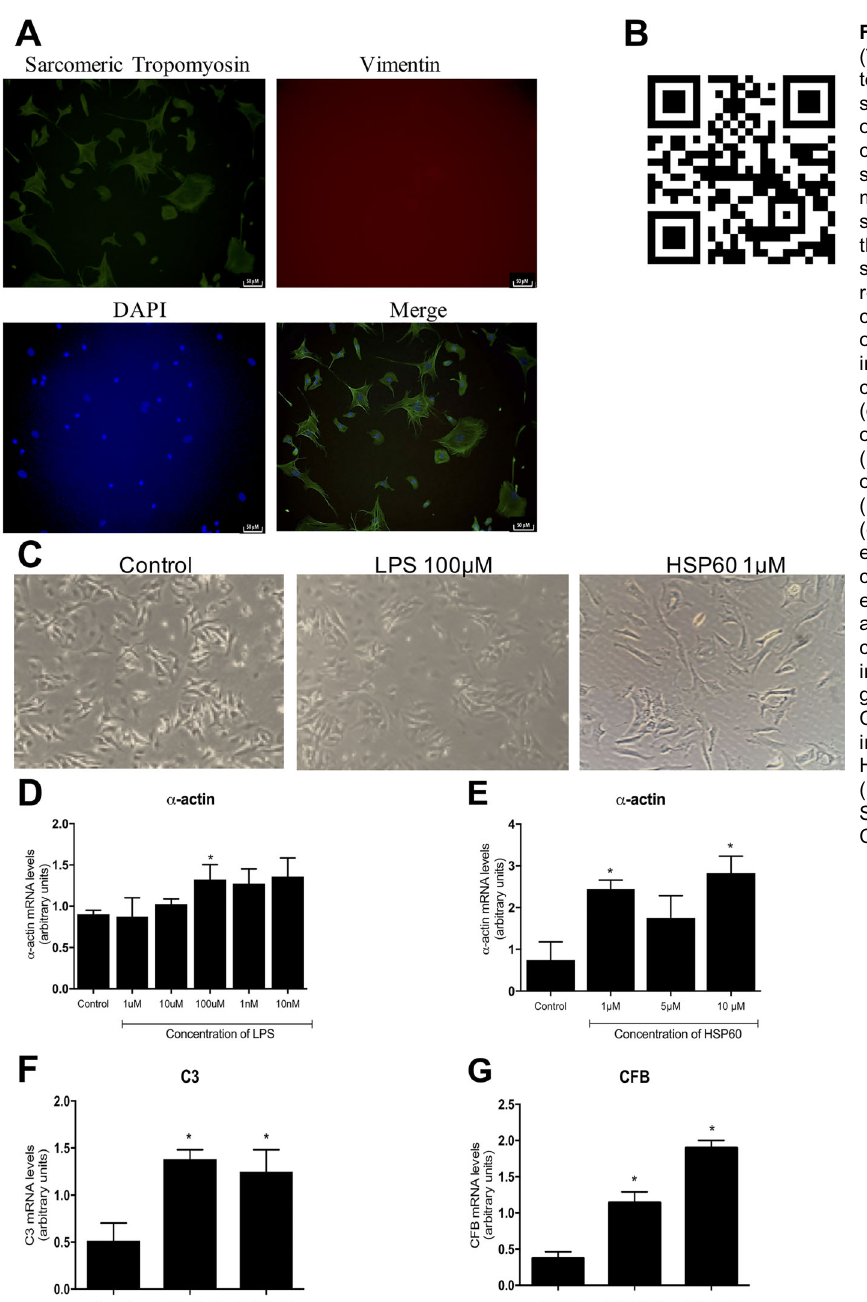
for silencing CaMKII d B expression. However, treatment with 100 Z M CaMKII d B siRNA for 48 h produced a faint protein band during western blotting analysis. This may be because western blotting analysis to detect CaMKII d B expression was performed using an antibody against total